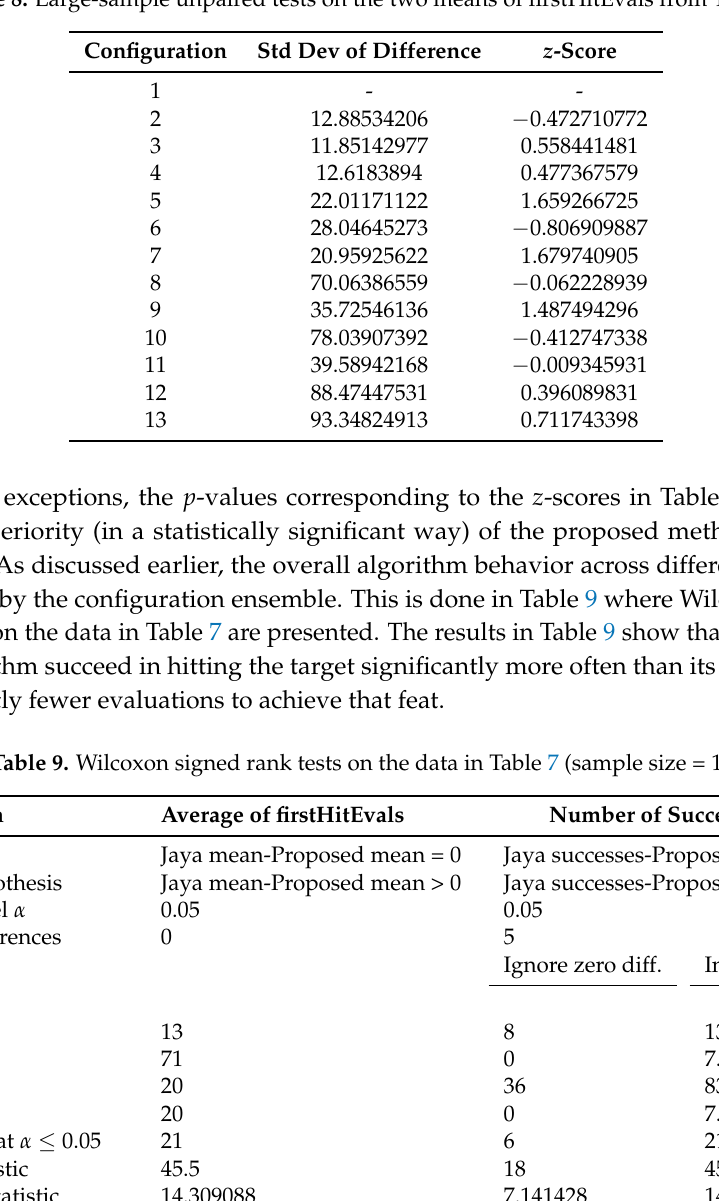
Table 8. Large-sample unpaired tests on the two means of firstHitEvals from Table 7.